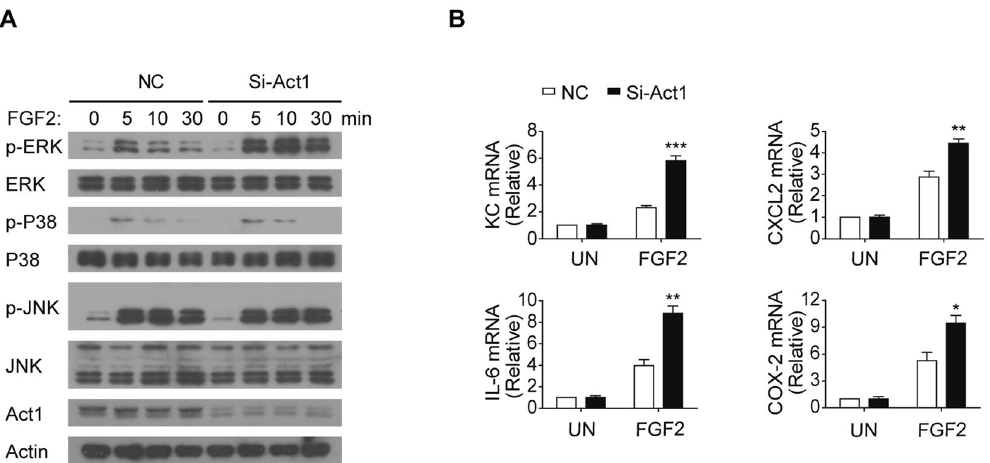
Figure 6. Act1 suppresses FGF2-mediated ERK activation. ( A ) Western blot analysis with antibodies against the indicated phosphorylated (p-) or total proteins in lysates of human primary FLS cells infected with control lentivirus or the lentivirus for Act1-specific siRNA (Si-Act1), and then left untreated (0) or treated for 5 to 30 min with FGF2 (50 ng/ml). ( B ) Quantitative mRNA expression of KC, CXCL2, IL-6 and COX-2 in human primary FLS cells infected as in ( A ) and then left untreated (0) or treated for 1 hr with FGF2 (50 ng/ml). Data are representative of three independent experiments (mean and s.e.m. in B ). * P < 0.05, ** P < 0.01, *** P < 0.001 by Student’s t